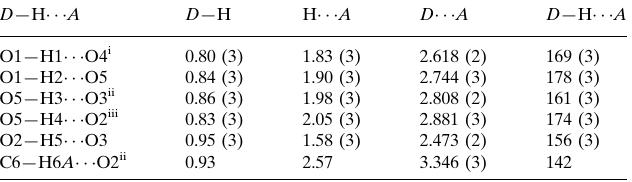
Hydrogen-bond geometry (A˚ , (cid:3)